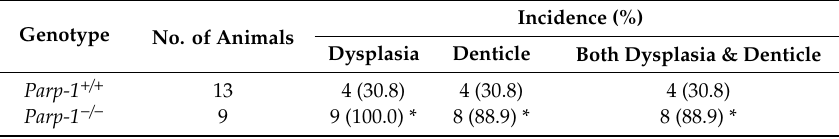
Table 1. Incidence of dental dysplasia of aged ICR / 129Sv mice.